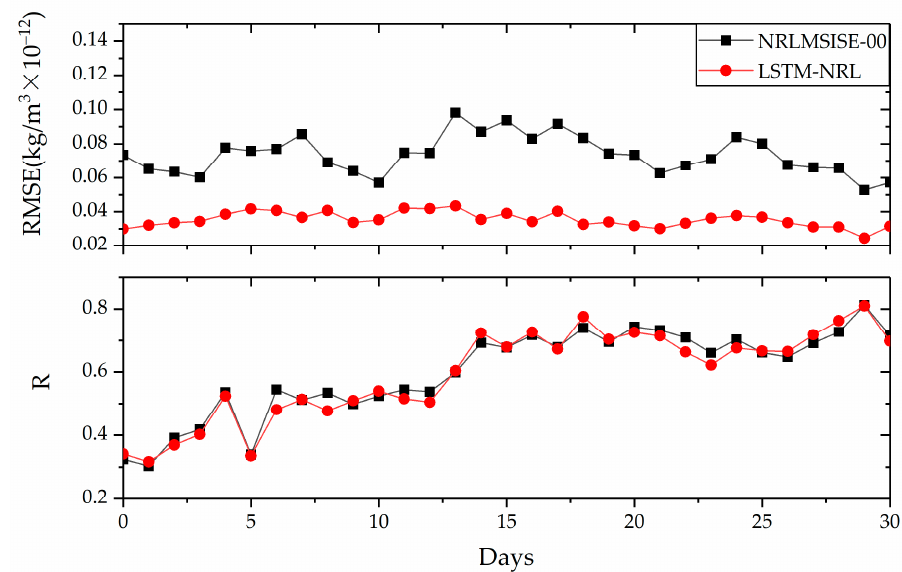
Figure 10. The daily RMSE and R values in January 2018, GRACE-A.